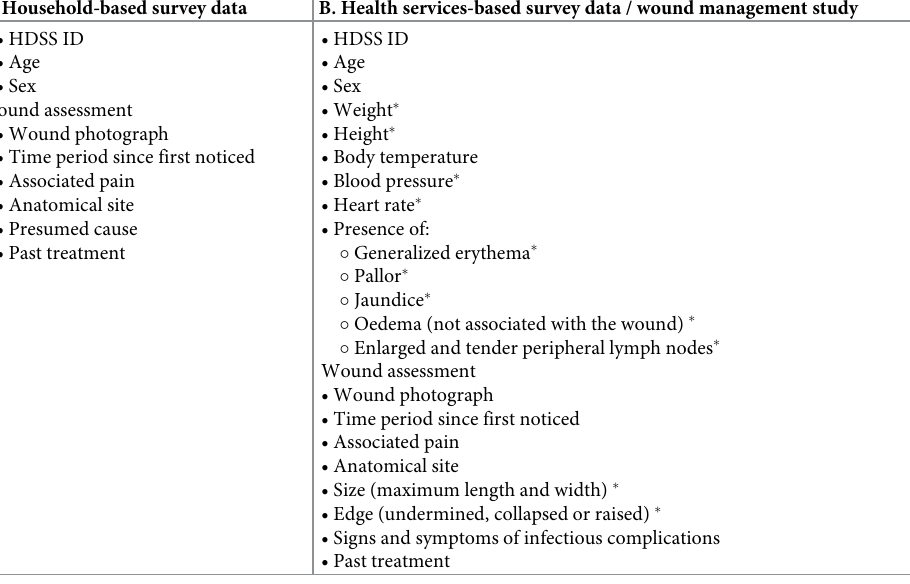
Table 1. Data collected during the household-based survey and the health services-based survey / wound manage- ment